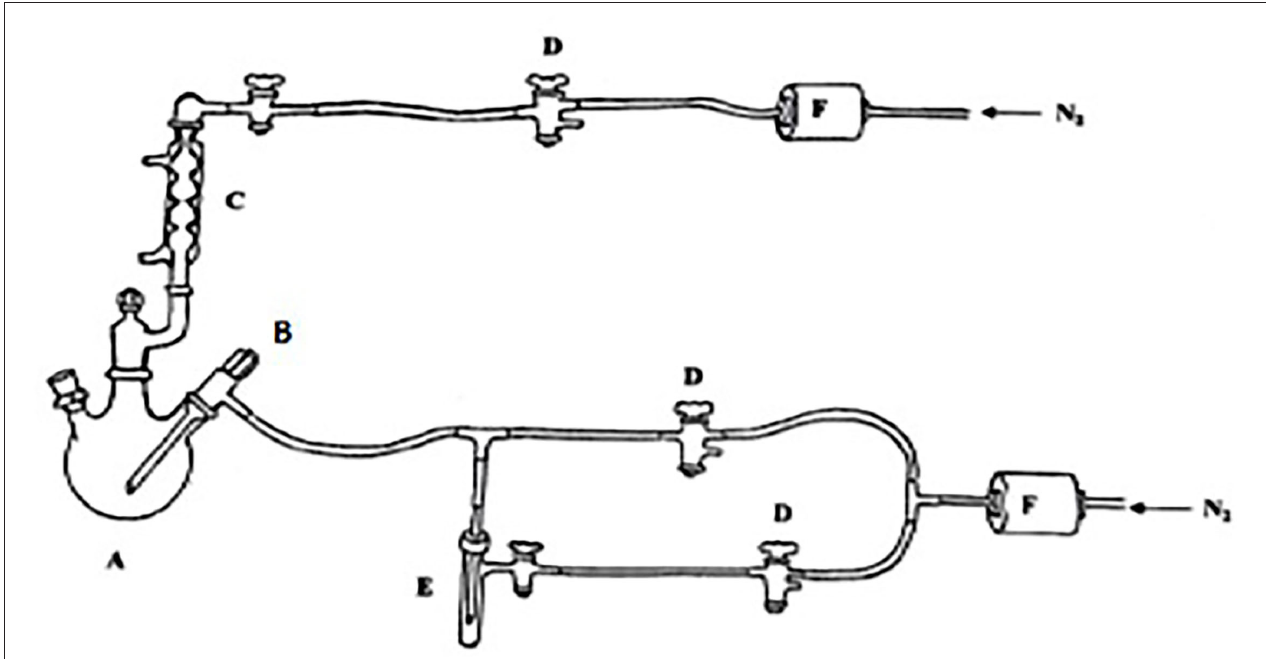
FIGURE 1 | Scheme of the wine production technical setup: (A) bio fermenter; (B) float for sampling; (C) coolant; (D) three-way taps; (E) sample collection tube, and (F) sterilizing gas filters.